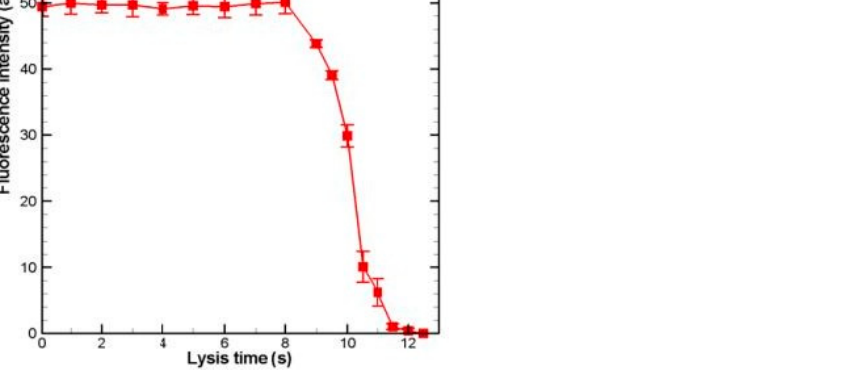
Figure 6. Fluorescence intensity of a single HeLa cell versus the time after the introduction of the lysis buffer shown in